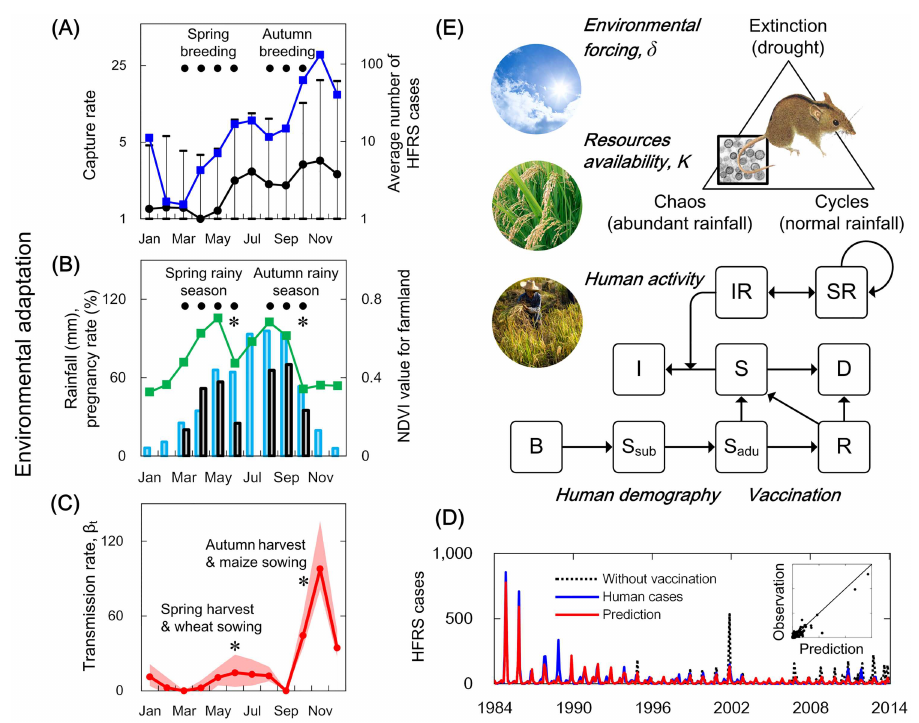
Fig 5. A simplified web of interactions involved in the ecology of hantavirus transmission. (A) Seasonal epidemicand rodent dynamics in Hu County, 1984–2014. Apodemusagrarius capture rates (black line) and 95% confidenceintervals (whiskers) are shown for 1984 to 2014. The blue line representsthe numberof HFRS cases. (B) Agriculturalphenologyand rodent dynamics. Time series of NDVI values of farmland(green line), rainfall(blue bars), and pregnancy rate of rodents (grey bars) [38] are shown. The timing of harvests ( * ) are denoted, as well as rainy seasonsand breedingseasons (black dots). The NDVI value for farmland, which increasesgraduallyduringthe growth periodof crops and suddenlydrops duringthe harvest season, was used to reflect the phenological changesof local crops. (C) Estimated seasonal transmission rate. Shadedregions are the 95% Bayesian credible intervals. Asterisks indicate agricultural activities for the spring harvest and wheat sowing, and autumn harvest and maize sowing. The agricultural activity may increasethe risk of human exposureto rodents. (D) Hantavirusinfectionsat the human-wildlife interface. The monthly numberof HFRS cases from 1984 to 2014 are shown; the blueline represents observedcases, the red line represents the deterministic prediction from the model (using the susceptible and infected individualsin the first month in 1984 as initial conditions), and the black line representsthe predicted outcome of the model without a vaccinationcampaignfrom 1994 to 2014. (E) An overviewof the system. The series of models link environment to host populationdynamics, hantavirusprevalencein rodents, and human demography. The model structures (solid lines) are established accordingto realisticecological processes. Susceptible individuals, S , were dividedinto different age groups, births, B , deaths, D , vaccinatedindividuals, V , immune individuals, R , infected individuals, I , susceptiblerodent hosts, SR , and infected rodent hosts, IR . The environmental forcing, δ , and resourceavailability, K , are incorporated into the model with parameters, which were consideredto play a significantrole in the fluctuationof rodent